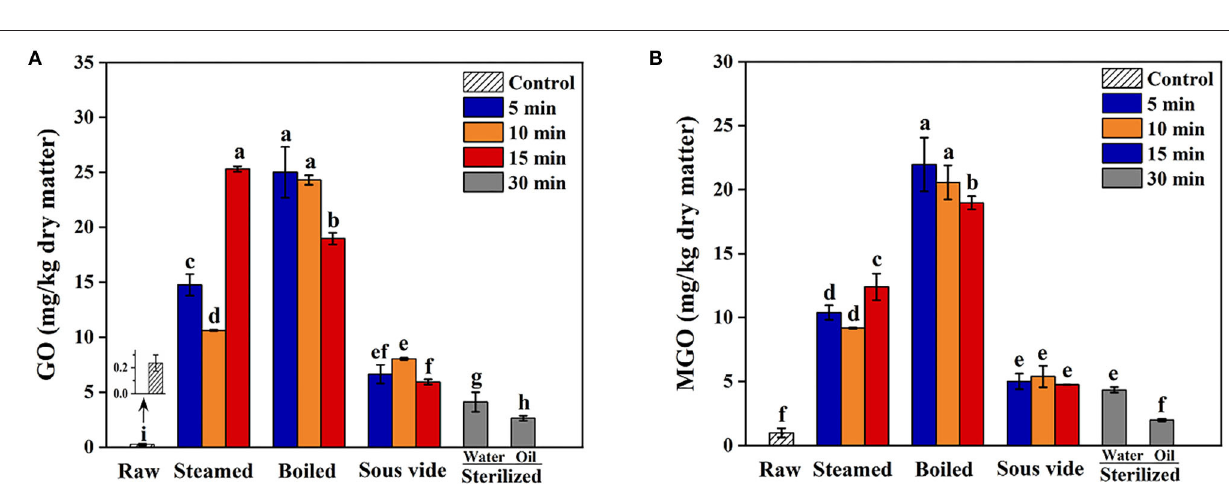
decrease in SO30 is still unclear. The finding of Tavares et